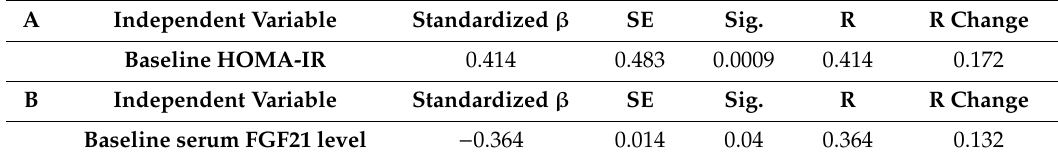
Table 3. Multiple regression analysis to assess predictors of percentile changes of hepatic steatosis index (HSI) during the VLCKD phase ( A ), and throughout the entire study period ( B ). Independent variables evaluated: Baseline FGF21, visceral adipose tissue mass (VAT mass), homeostasis model assessment-insulin resistance